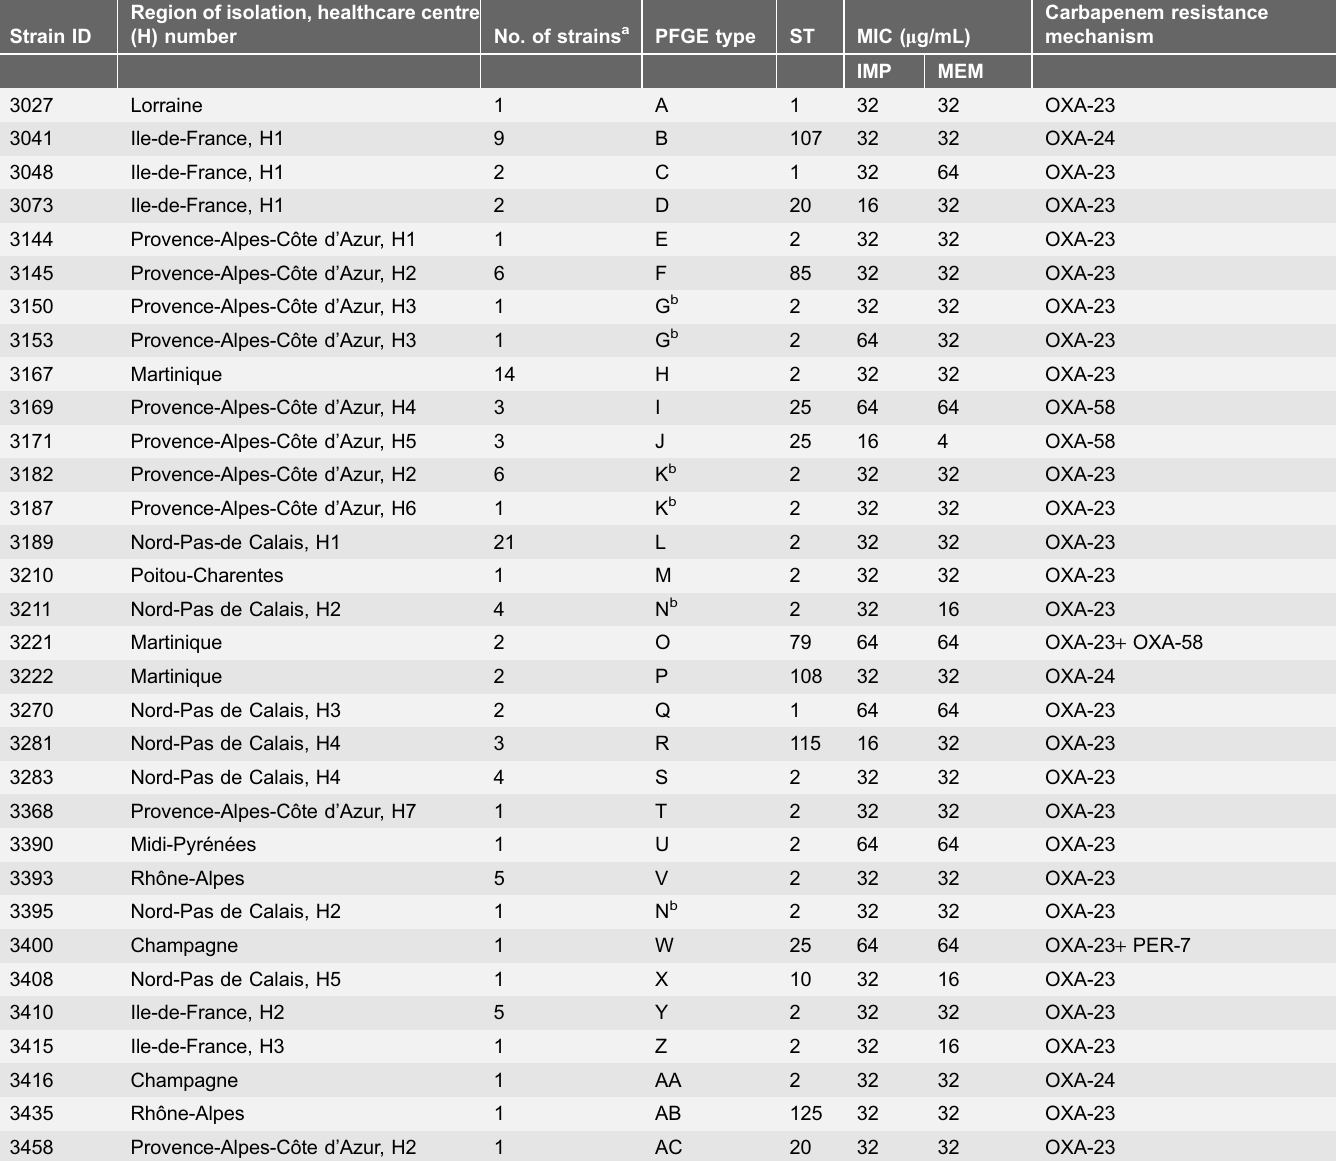
Table 1. Epidemiological, phenotypic and genotypic features of the A. baumannii studied. Region of isolation, healthcare centre Strain ID (H)